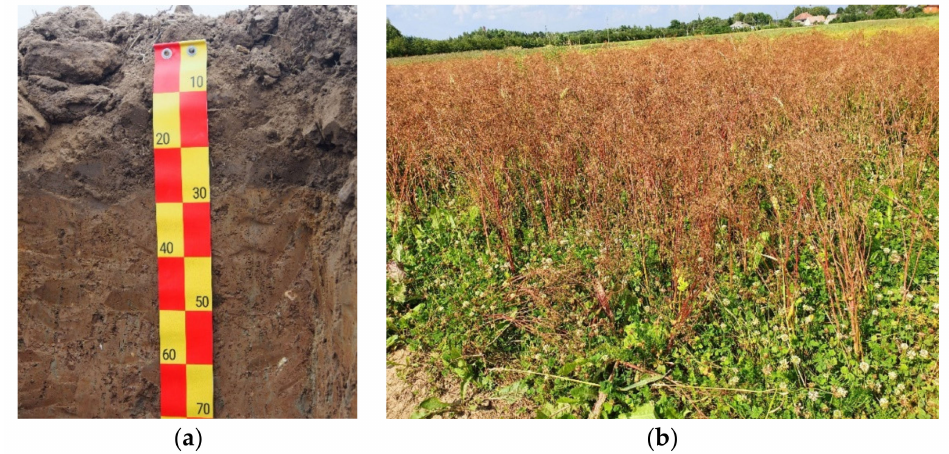
Figure 5. Experimental site: ( a ) actual, layers of the soil; ( b ) trinary crop of spring barley intercropped with caraway and white clover in the third year of caraway vegetative season in 2019. A 1-factor field experiment with 10 treatments was set up in 2017 (Figure 6). The experiment was performed in four replications, and a randomized complete block design (RCBD) was used. The size of each experimental plot was 60 m 2 (5 m × 12 m), one replication block was 600 m 2 ; 2 m buffer rows were left between the individual blocks. There were 40 plots in total in the experimental field.